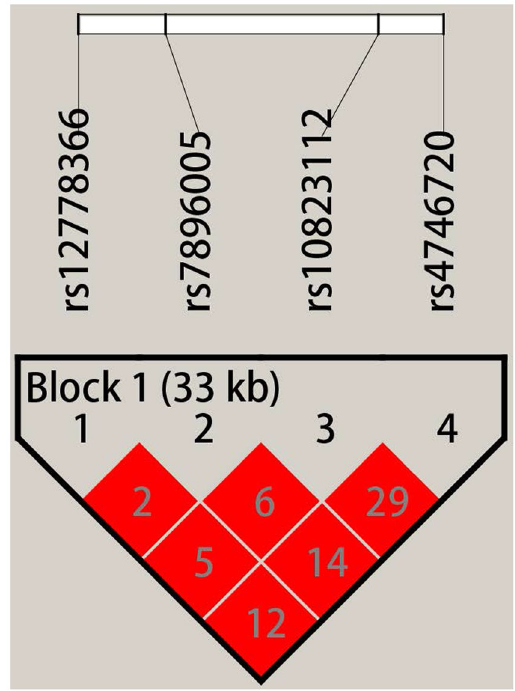
Figure 1. Four tagSNPs haplotypic block analysis.